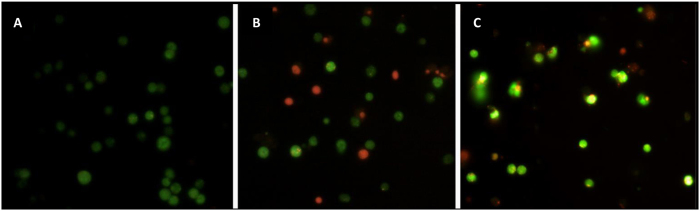
Effect of IC50 of SWCNT and MWCNT on PC12 cell apoptosis and necrosis.The mode of cell death [(MWCNT-treated cells (B), SWCNT-treated cells (C)] (different necrotic or apoptotic cells) was detected by using AO/EB dual staining method in comparison with control cells, which appeared uniformly stained green in color (A).